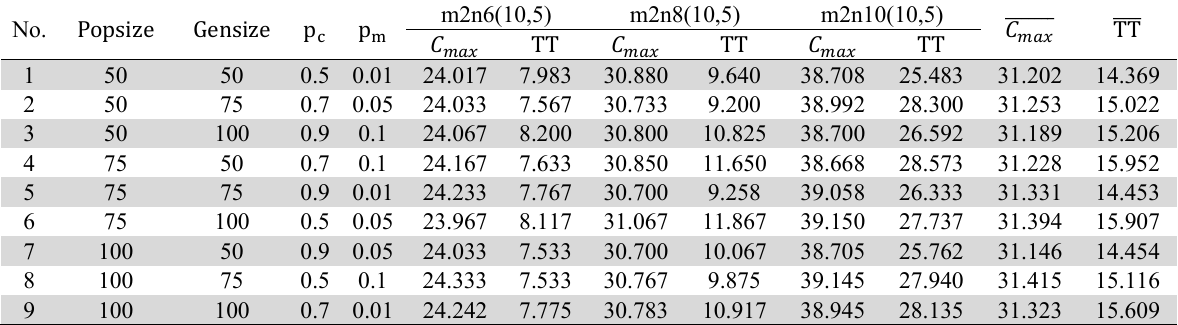
Orthogonal results for the small-scale instances